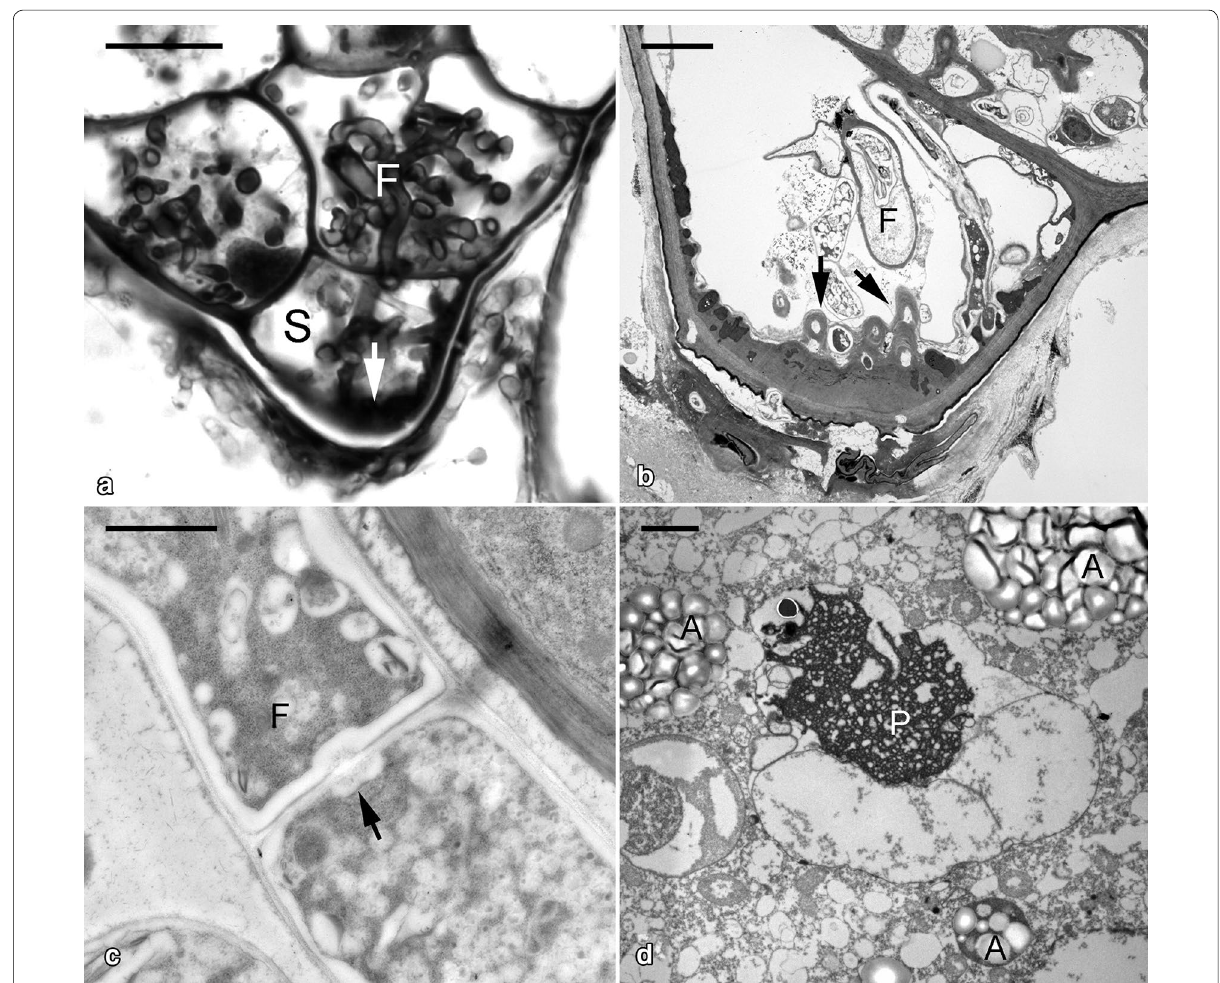
Fig. 2 Micrographs showing the germinating embryo of G. elata associated with Mycena . a Light micrograph of the suspensor end cell (S) colonized by fungal hyphae (F) with cell wall thickening (arrow).Scale bar papillae‑like cell wall thickening (arrows) corresponding to the entry of fungal hyphae. Scale bar is present in the primarily colonized cells. The dolipore septum (arrow) can be observed at the junction between fungal cells. Scale bar the uncolonized embryo cells, the storage protein bodies (P) are degrading and amyloplasts (A) start to appear. Scale bar